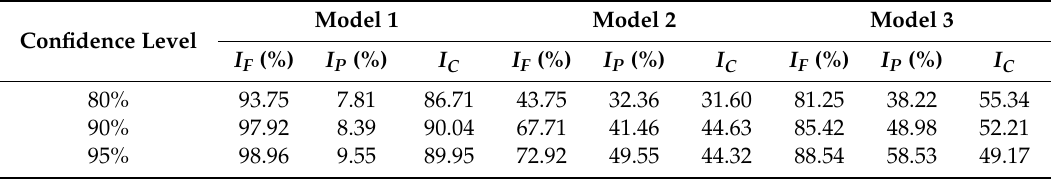
Table 2. Models comparison at di ff erent confidence